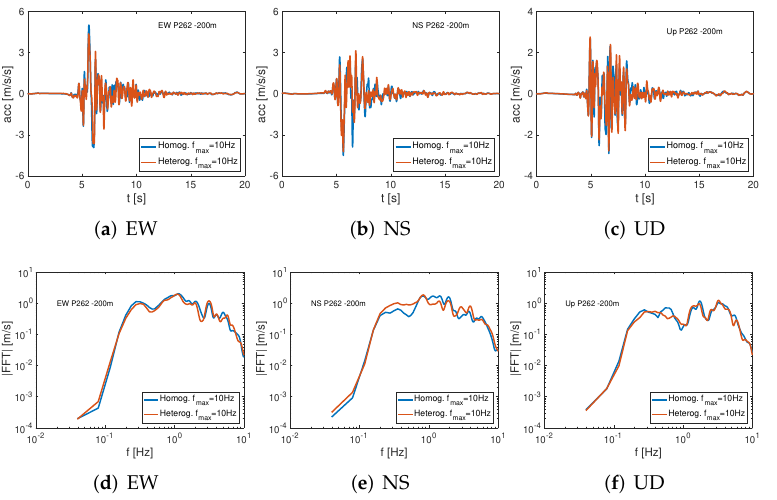
Figure 13. Horizontal and vertical PGA contour plot from F5 simulation in the surroundings of the Argostoli sedimentary basin. ( a ) Geometric horizontal average peak ground acceleration a max . ( b ) Vertical peak ground acceleration a max .